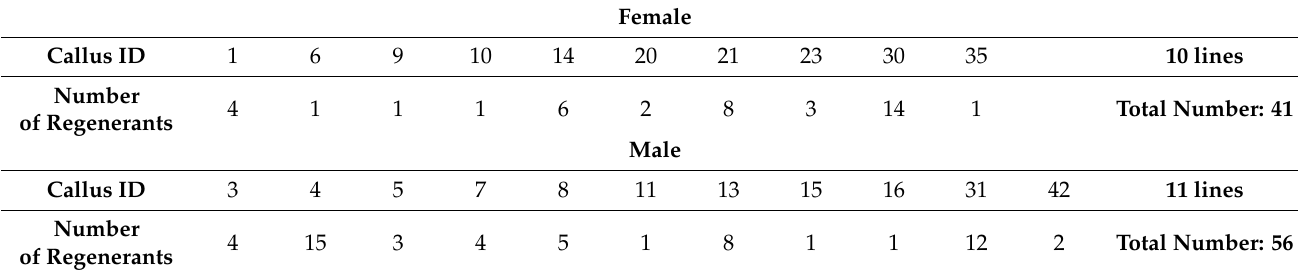
Table 1. Twenty one endosperm-derived calli lines and 97 regenerated plants of Actinidia chinensis var. deliciosa analyzed with sex-linked molecular markers SmX and SmY